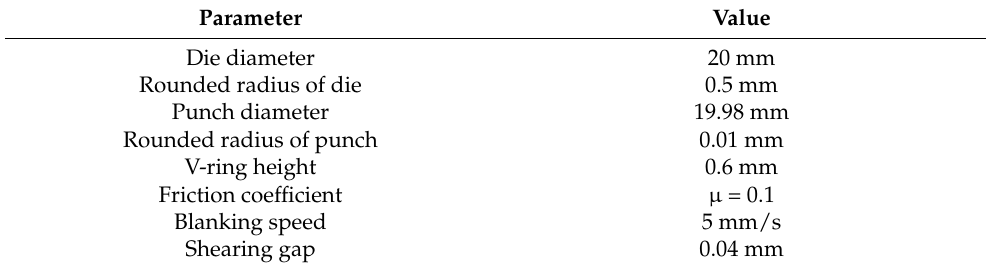
Figure 2. Schematic diagram of finite element model. Table 3. Important parameters of the finite element simulation.